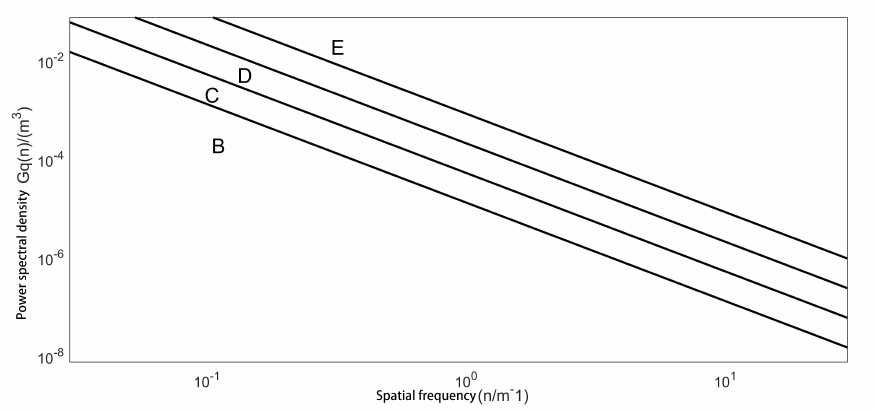
Figure 5. The road grade distribution.